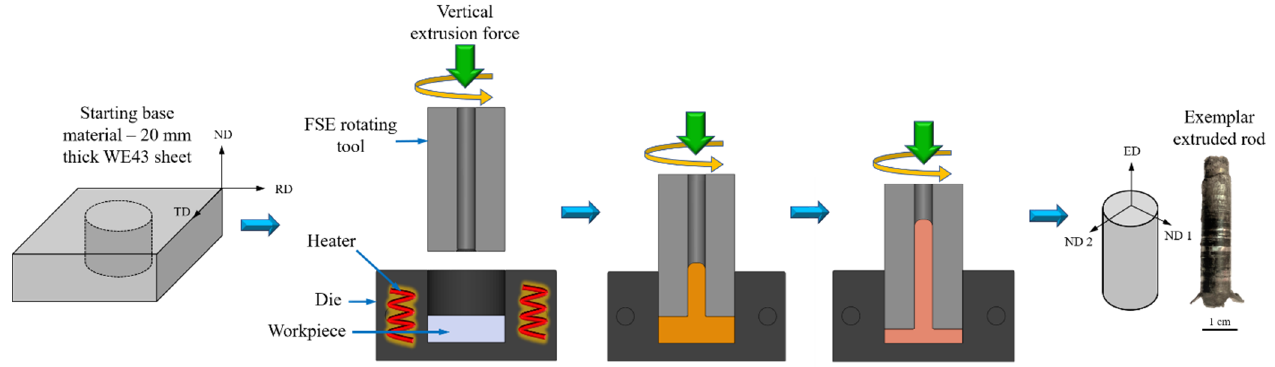
Figure 1. A schematic of the friction stir extrusion process showing tool and die with a heating coil. An example extruded WE43 Mg alloy rod of 1 cm diameter is also shown.